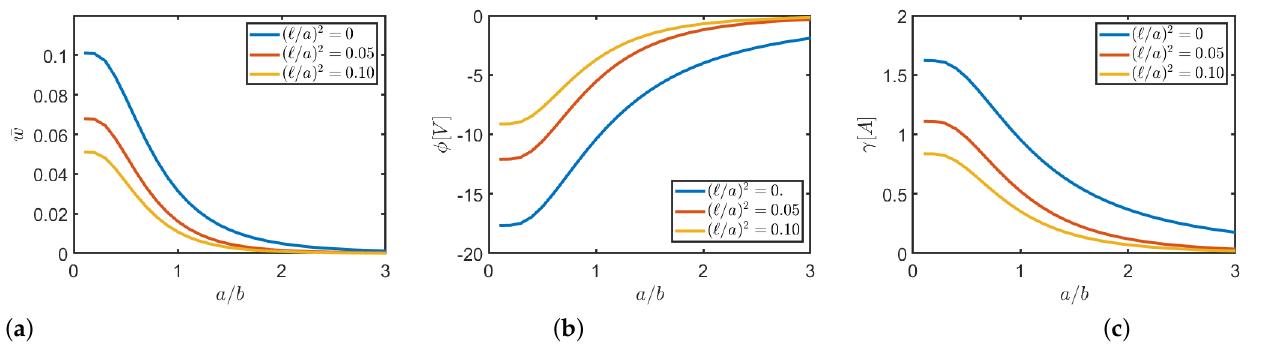
Figure 8. Displacement ¯ w ( a ) electric φ ( b ) and magnetic γ ( c ) potential, at the central point ( a /2, b /2 ) by varying a / b and for different nonlocal parameters ( (cid:96) / a ) 2 with n p = 1 (UDL; q = 10 3 N/m 2 , T 0 = T 1 = 0 K, ρ E = 0 C/m 2 , ρ H = 0 Wb/m 2 ).